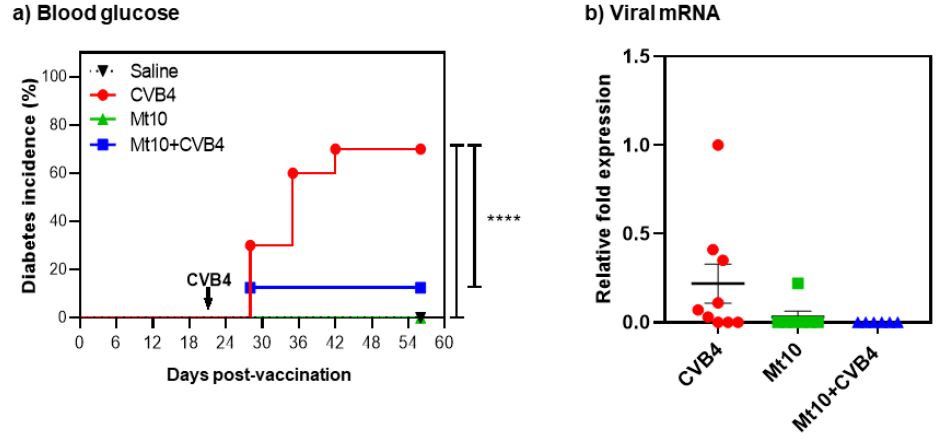
Figure 2. Mice vaccinated with Mt10 vaccine virus show enhanced protection against diabetes incidence. ( a ) Blood glucose. Blood glucose levels were monitored weekly, and diabetes incidence is shown. Mice with a blood glucose level of >300 mg/dL on two consecutive readings were deemed diabetic. Data sets obtained from each group involving n = 5 – 9 mice are shown. Log-rank test with Bonferroni correction was used to compare diabetes incidence. ( b ) Viral mRNA. Groups of mice were given saline or were vaccinated with Mt10 virus, and 7 days later were challenged with or without CVB4. Pancreata were collected 5 weeks post-challenge, total RNA was extracted, and viral RNA was estimated by RT-qPCR using VP1-specific nucleotide sequences. After normalizing the expression levels of viral RNA relative to GAPDH, 2 −(∆∆Ct) values were calculated. Mean ± SEM values representing 5 – 9 samples per group are shown. Mann–Whitney U test and one-way ANOVA with Tukey’s multiple comparison test was used to determine significance between groups. **** p ≤ 0.0001.